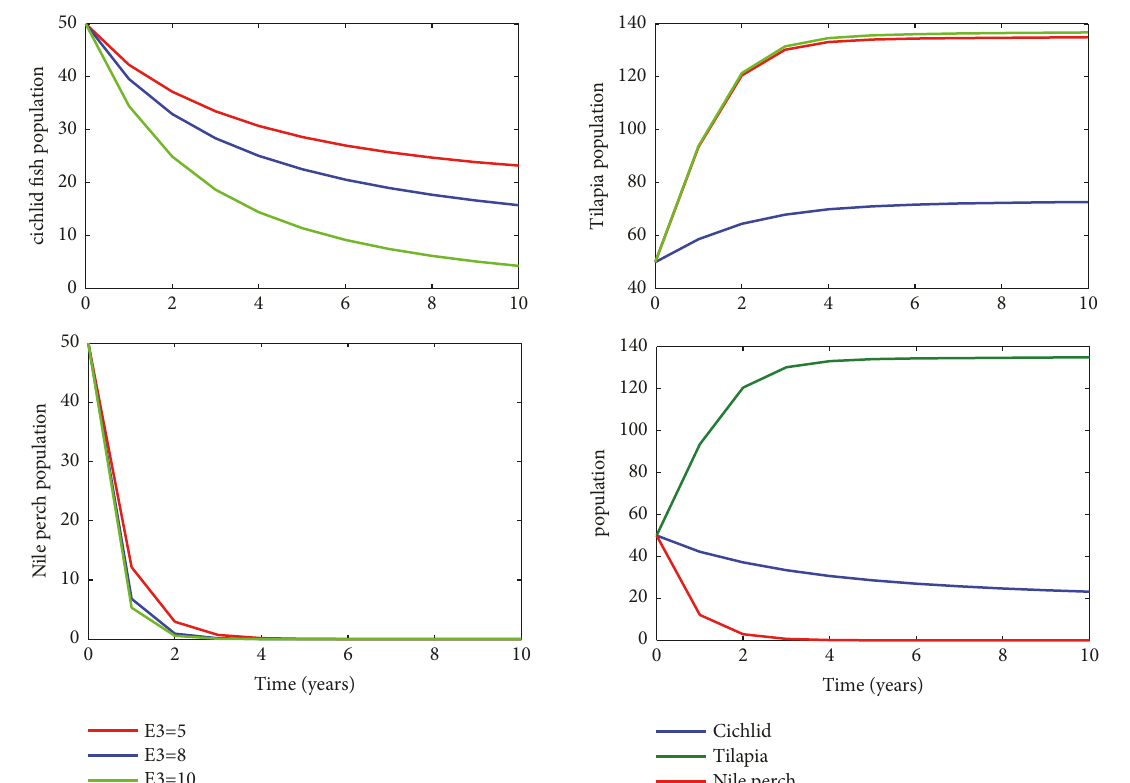
Figure 5: The effect of Nile perch harvest with different values of 𝐸3 with fixed values of 𝐸1 and 𝐸2 .